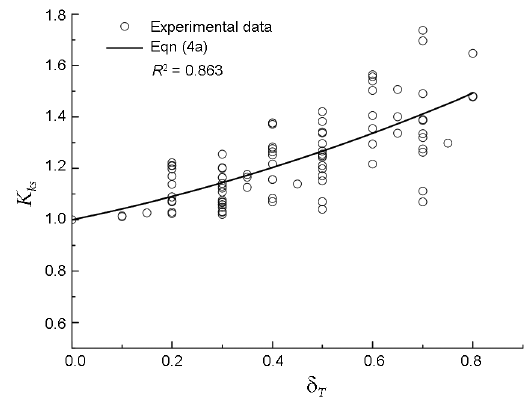
Figure 1. Relationship between K ks and concrete tensile stress ratio